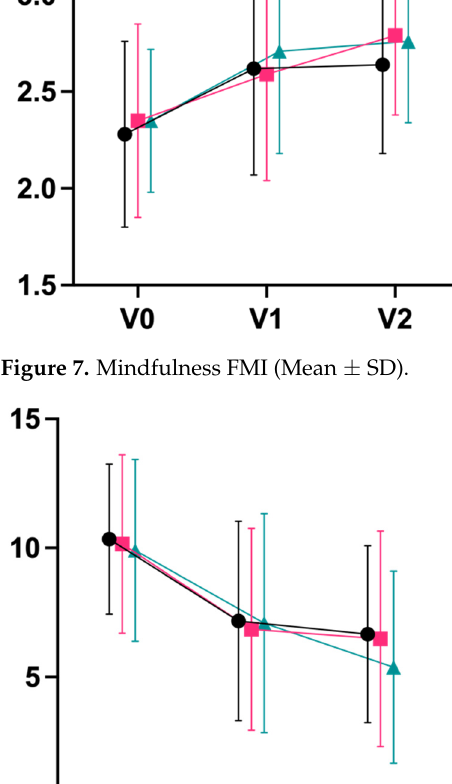
Figure 8. Anxiety HADS (Mean ± SD).